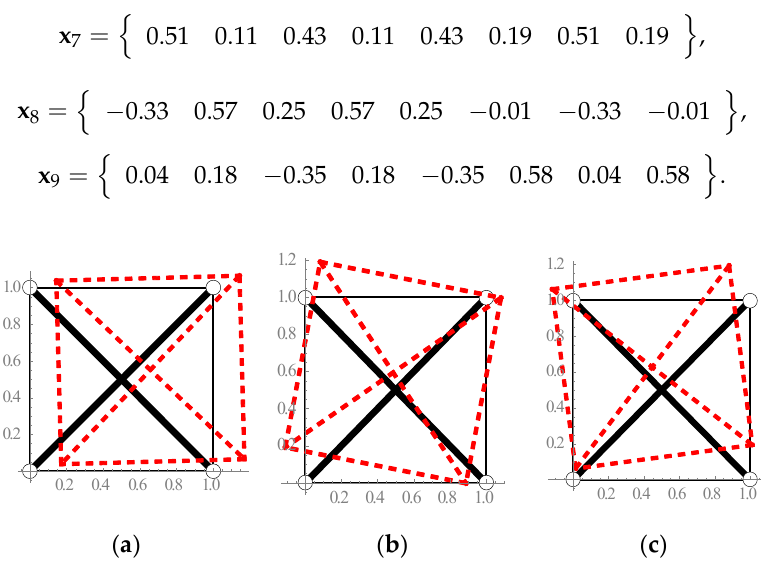
Figure 2. The “X” truss: ( a ) supported, ( b ) unsupported.